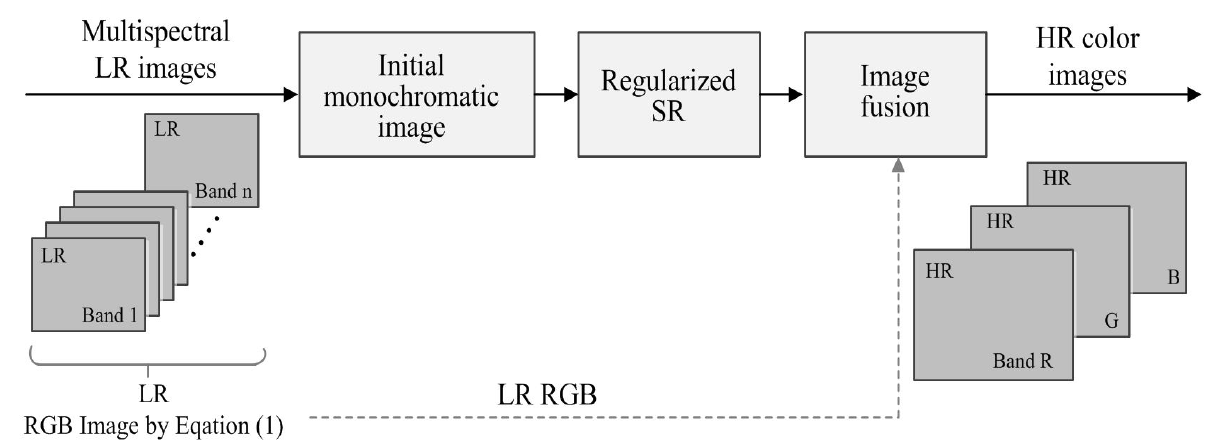
Figure 2. Block-diagram of the proposed super-resolution